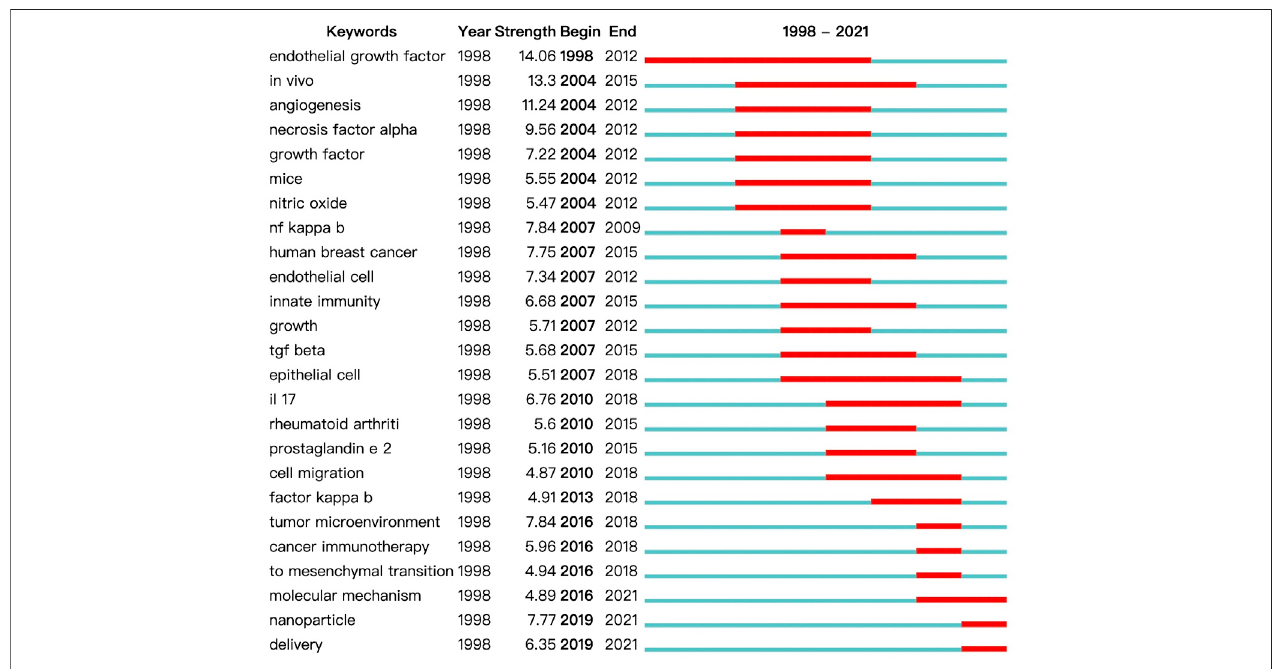
Frontiers in Pharmacology |